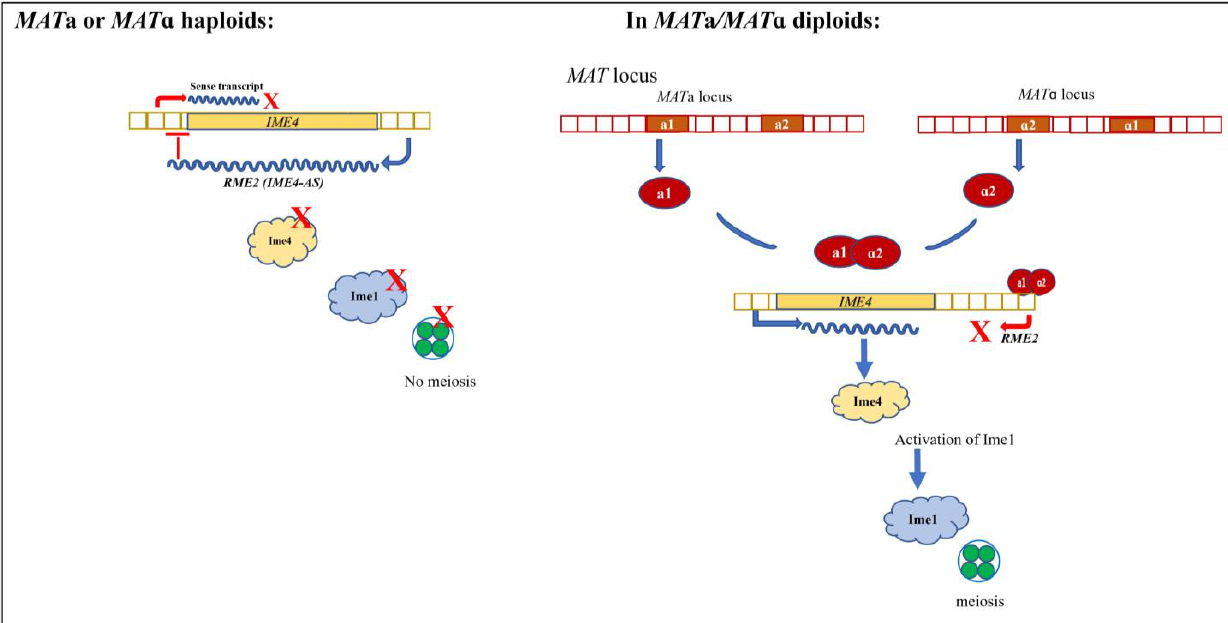
Figure 1. Cell-type-specific control of meiosis via antisense non-coding RNA: Ime4 is an activator of IME1, the master regulator of meiosis. In haploid MAT a and MAT α cells, an antisense transcript, RME2, is produced from the IME4 locus. RME2 represses the expression of Ime4 by potentially preventing the elongation of the IME4 RNA. Therefore, haploid cells do not progress to meiosis. On the other hand, in heterozygous MAT a/ MAT α diploids, a1 and α 2 expressed from the mating-type MAT a and MAT α locus form the a1- α 2 repressor complex. This repressor complex binds to binding sites present downstream of the IME4 locus, thus repressing the antisense transcription . Therefore, in the absence of RME2, the IME4 sense transcript is created and Ime4 is expressed, which can now activate IME1 expression and initiate meiosis.